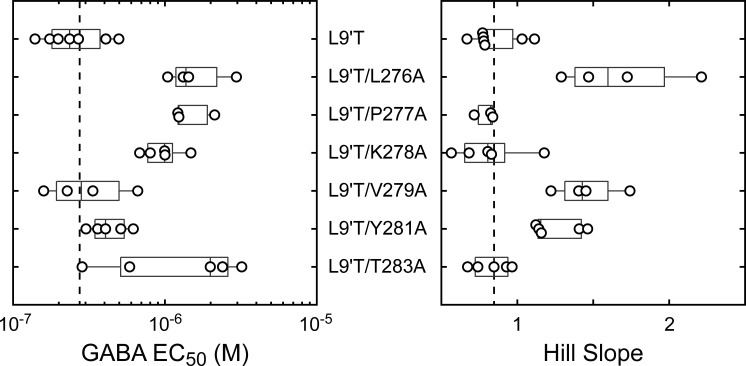
Summary of GABA EC50 and hill slope from fitting Equation 1 to GABA concentration–response relationships as shown in Figure 2 for individual oocytes.Gray box plots indicate the median and 25th and 75th percentiles. The vertical dashed line is the mean for L9'T.